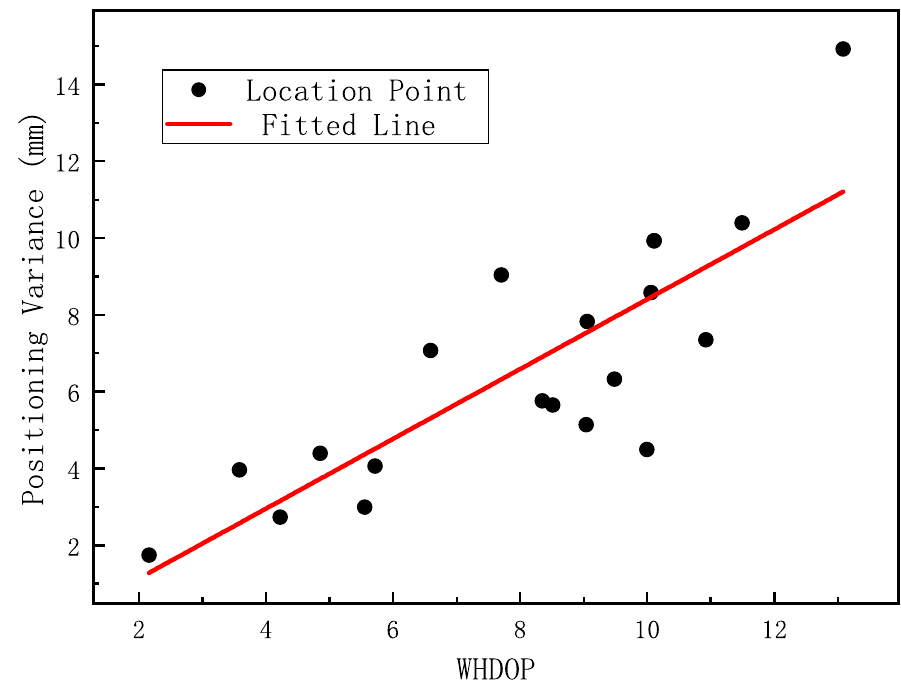
Figure 11. WHDOP and positioning residual fitting line.